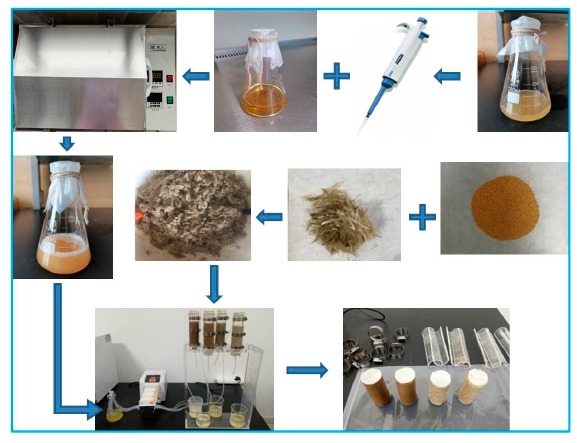
Figure 2. The process of sample